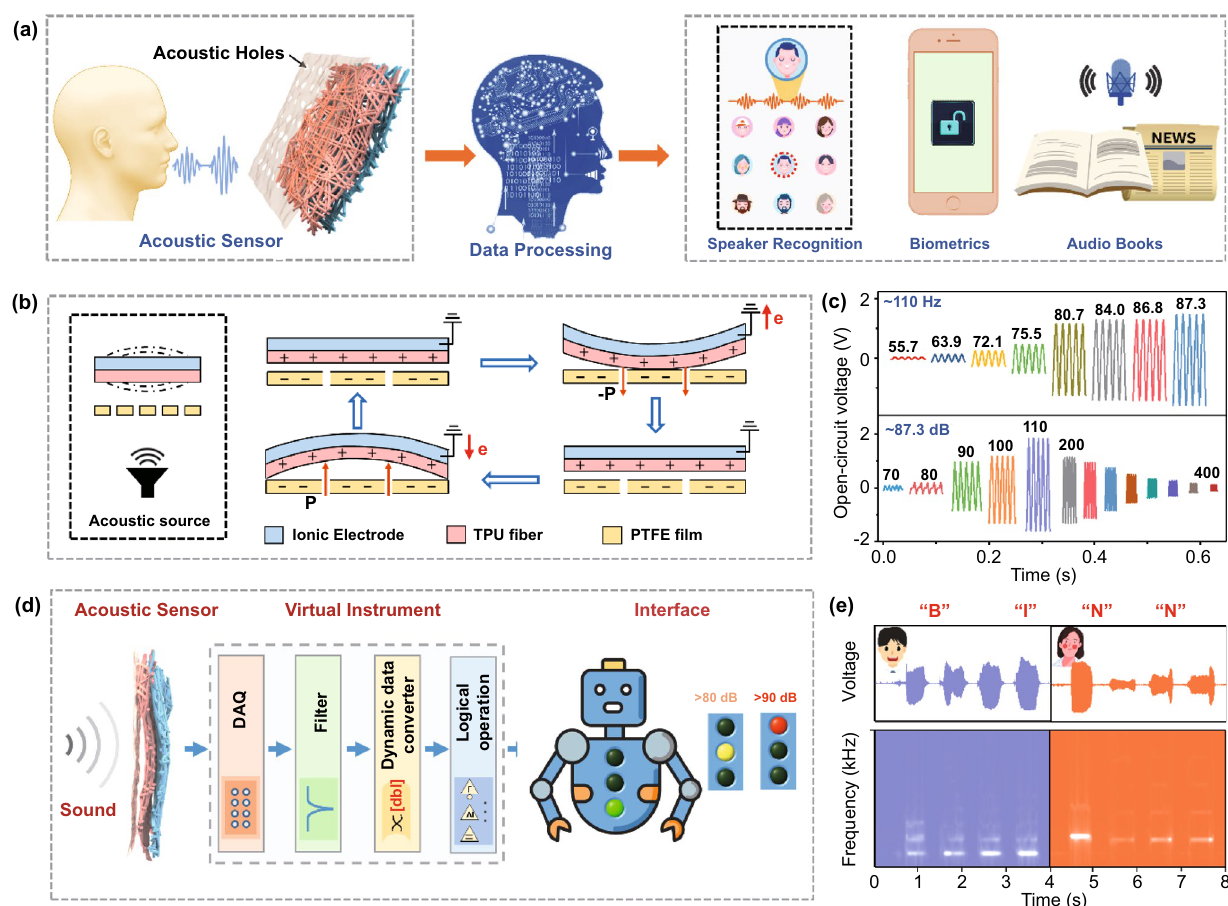
Fig. 5 Acoustic biometrics applications of the ITM. a Expectation for intelligent biometric applications through the collaboration of the high- sensitivity ITM and the machine learning algorithms; b cross-sectional scheme for the working mechanism of the ITM during the vibration caused by sound waves; c voltage signal measured from the ITM when varying the acoustic frequency and SPL; d virtual sound detect robot interface for monitoring noise level; e voices recorded from a male and a female and the corresponding frequency spectrogram with simple let- ters (“B,” “I,” “N” and